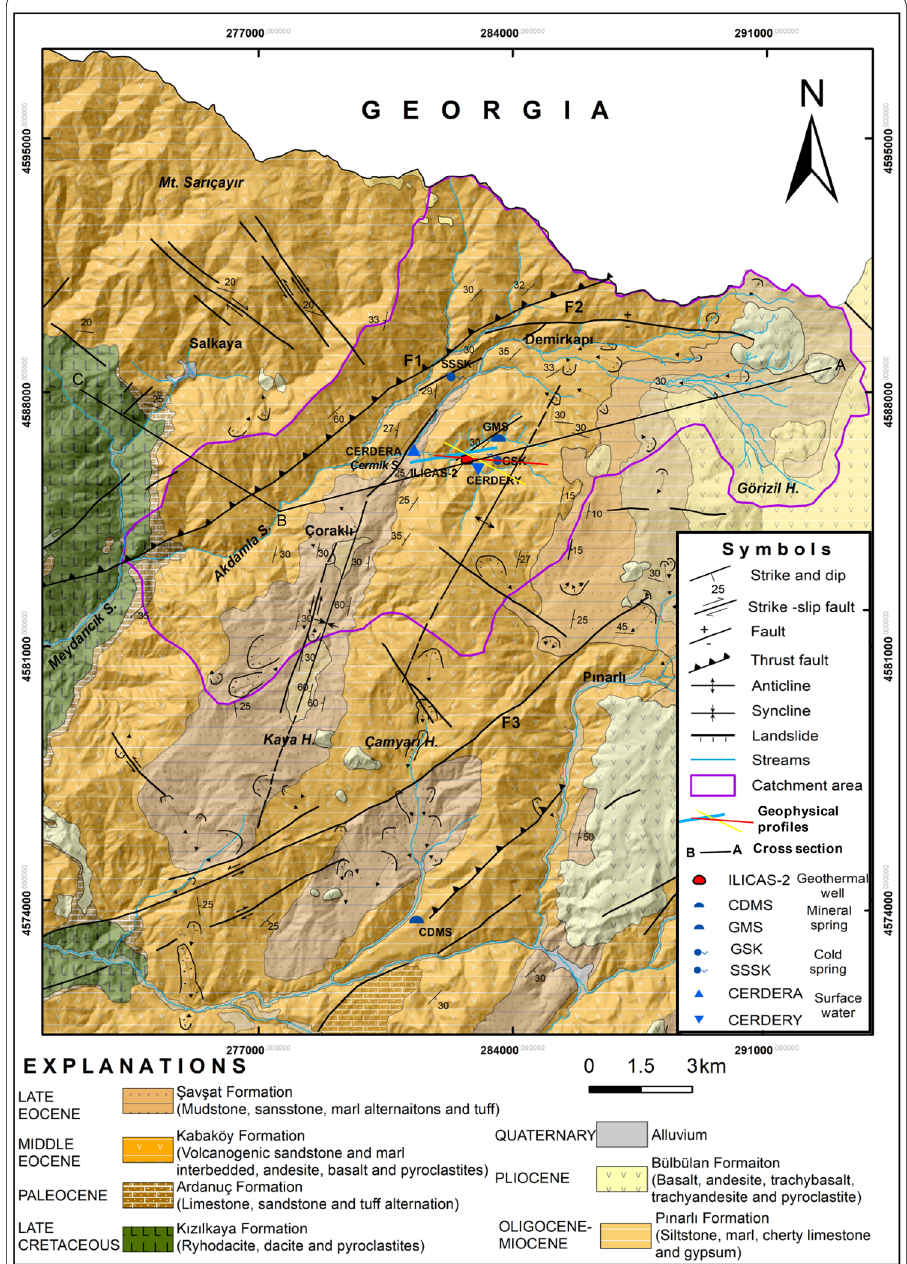
Fig. 4 Geological map of the Şavşat (Artvin/Turkey) Geothermal Field (revised from Erendil et al. 1989 and Konak et al.